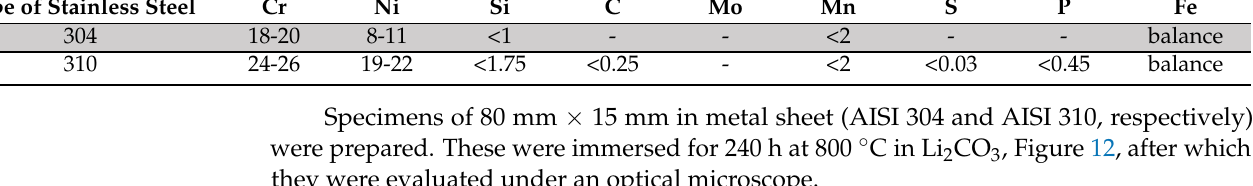
Figure 11. Micrograph corresponding to cross section of the container after tests: oxide layer.